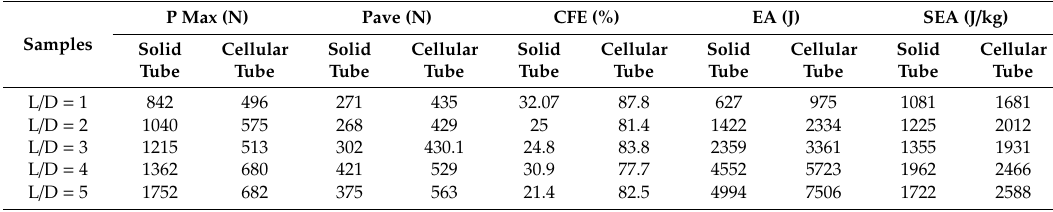
Table 5. FE results for crashworthiness